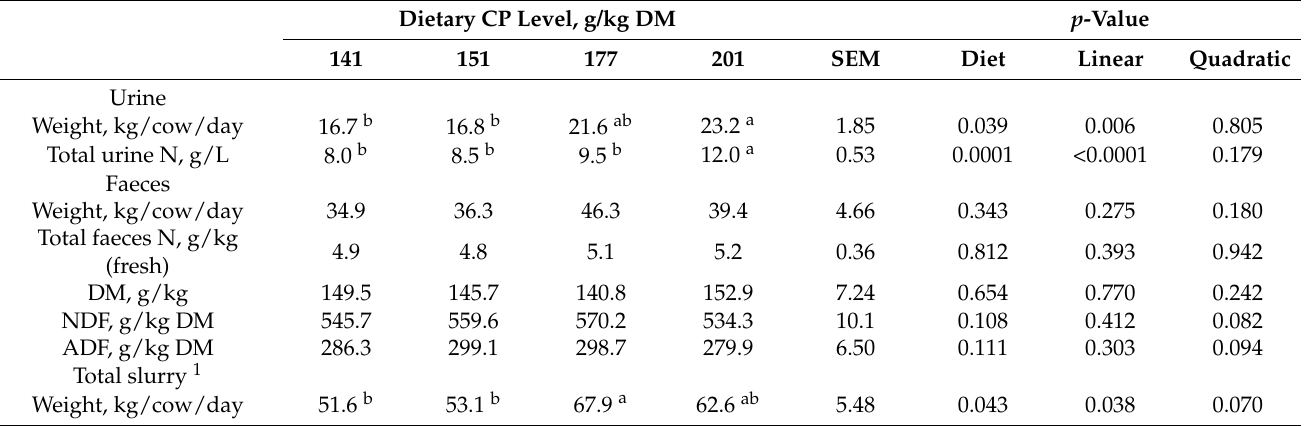
Table 2. Weight and chemical characteristics of the urine and faeces combined to form the slurry samples. Dietary CP Level, g/kg